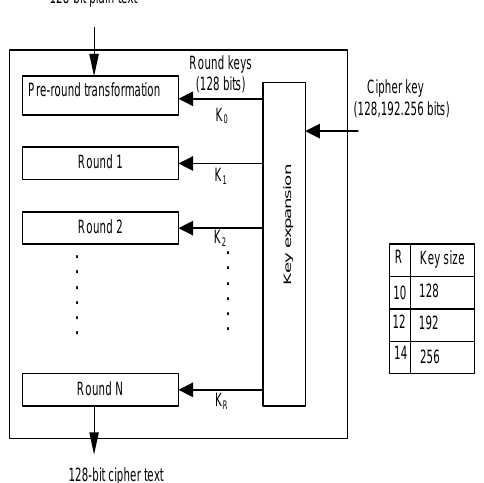
Figure 3 . Block diagram representation of